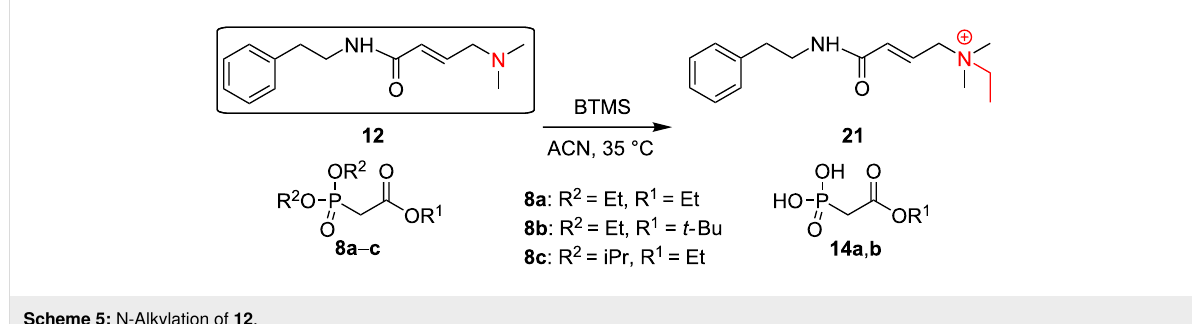
Scheme 5: N-Alkylation of 12 .